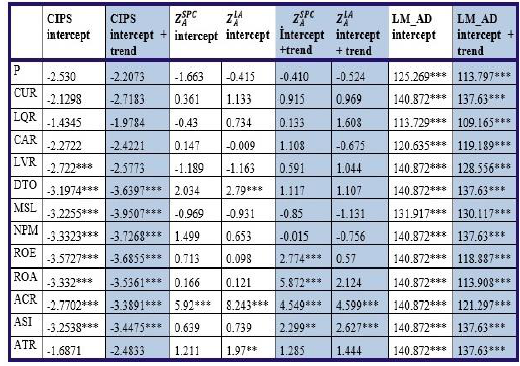
Table 2: Cross-Section Dependence and Panel Unit Root Test Results for Companies Traded in Turkey